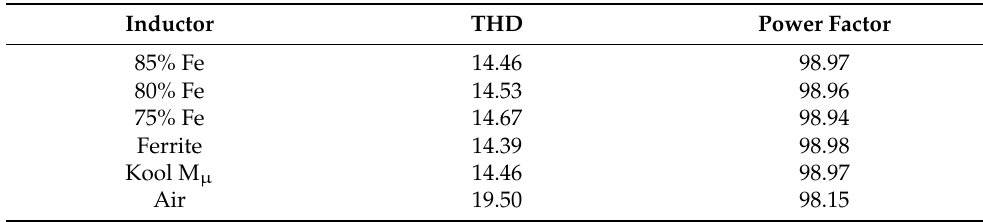
Table 3. Total harmonic distortion (THD) and power factor (PF) at 800 kHz switching frequency in the input